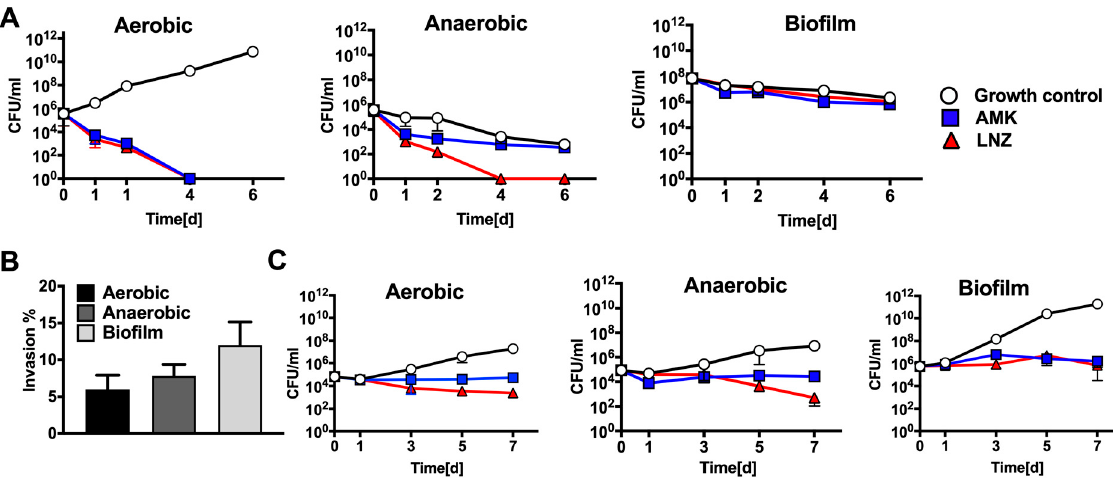
Figure 1. Antibiotic killing kinetics in vitro and in cultured macrophages. ( A ) Time-kill curves of M. abscessus subsp. abscessus (MAB) under aerobic, anaerobic and biofilm conditions and using bactericidal concentrations of amikacin (AMK) and linezolid (LNZ) show viable bacterial colony forming units (CFUs) over 6 days. Antibiotics were added to bacterial culture in 7H9 broth at time zero, and drug treatment groups were compared to MAB growth control. ( B ) Macrophage invasion assay demonstrates that MAB of biofilm phenotype invaded cells at a higher rate than bacteria of aerobic and anaerobic phenotypes. THP-1 cells were infected as described in the materials and methods, and the percentage of invasion was calculated as the percentage of intracellular bacteria recovered at 2 h infection to initially applied inoculum. ( C ) MAB survival rates in THP-1 macrophages display bacterial number of the aerobic, anaerobic, or biofilm phenotype recorded over 7 days with and without AMK and LNZ treatments. Antimicrobials were added to culture monolayers at 2 h of infection and then every alternate day. Growth control without drug treatment is also shown.